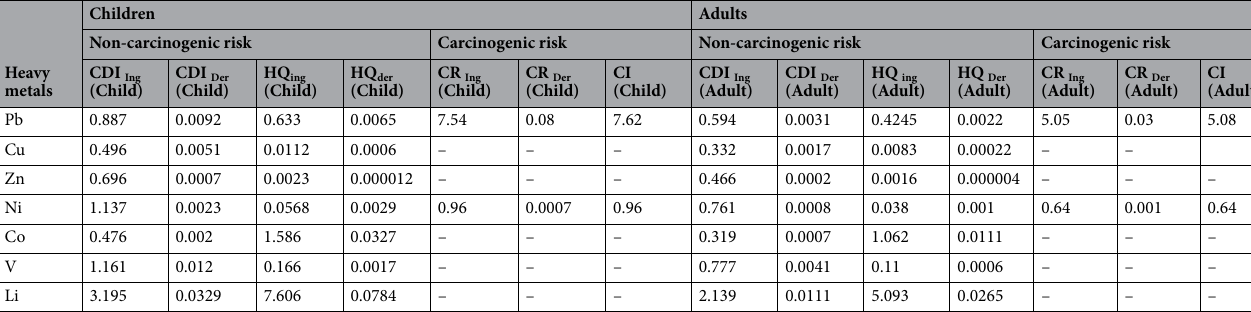
Table 4. Carcinogenic and non-carcinogenic health risk assessment of heavy metals in groundwater for children and adults. CDI chronic daily intake, Ing ingestion, Der dermal, HQ hazard quotient, CR carcinogenic